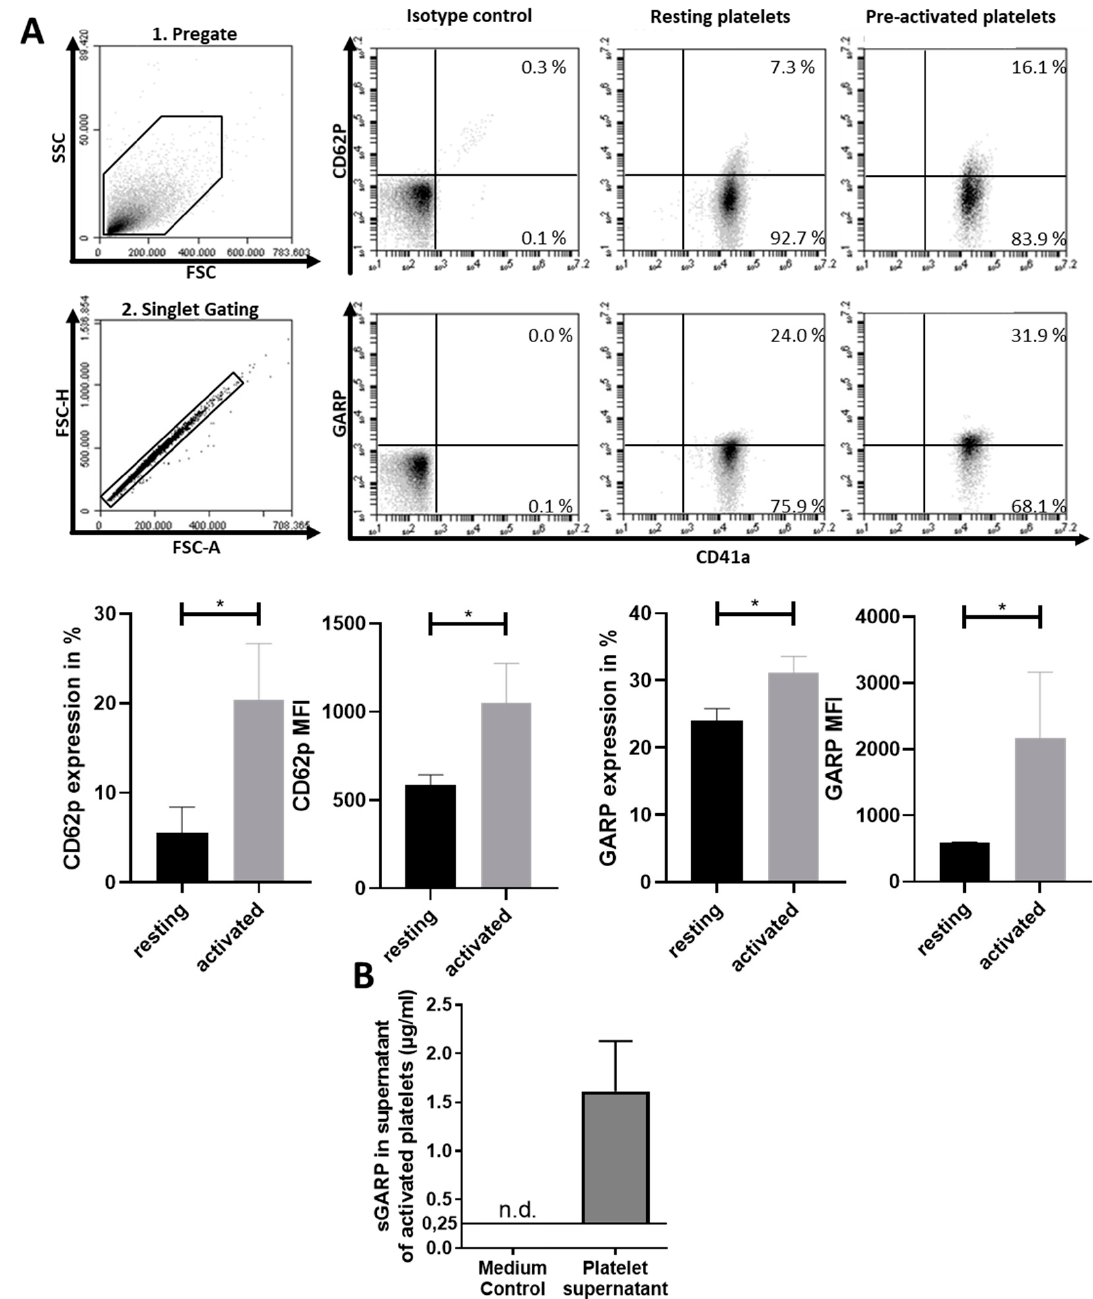
Figure 1. Glycoprotein A repetitions predominant (GARP) was expressed on the surface of platelets and was detectable in the supernatant of activated platelets. ( A ) Flow cytometric analysis of CD62P and GARP expression levels in resting and pre-activated platelets. Only singlets were used in the analysis. Isotype controls are shown. Bar diagrams of CD62P and GARP expression show pooled data of percentages (%) of positive cells and raw means ( n = 3, means ± SD * p < 0.05, and n.s. determined by Student’s t -test). ( B ) Presence of soluble GARP (sGARP) in the supernatant of pre-activated platelets. sGARP content of the supernatant of 2 × 10 9 activated platelets after 16 h compared to a negative medium control (n.d. = not detected). sGARP levels were determined by ELISA from three di ff erent healthy donors